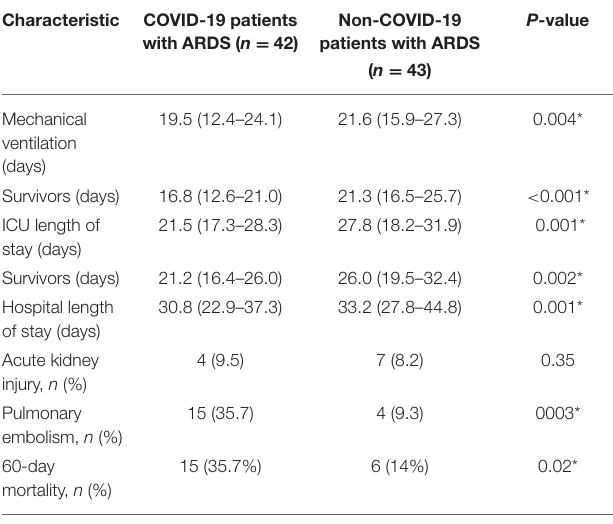
TABLE 5 | Complications and outcomes of forty-two COVID-19 patients and forty-three non-COVID-19 patients with acute respiratory distress syndrome. Characteristic COVID-19 patients Non-COVID-19 with ARDS ( n = 42) patients with ARDS